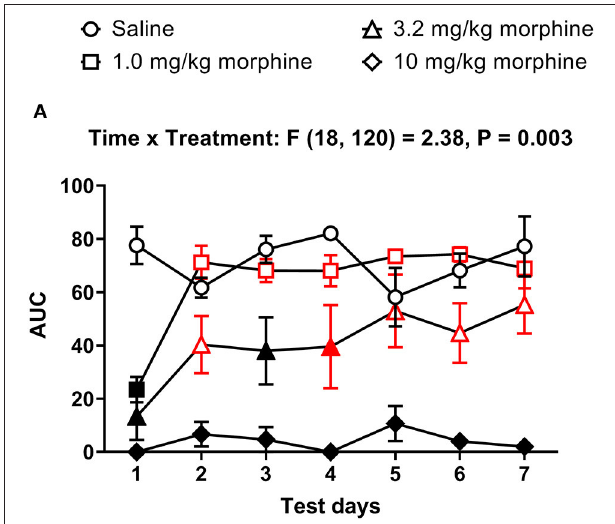
FIGURE 5 | Time course of repeated morphine treatment on nesting behavior. (A) The area under the curve (AUC) of nesting scores recorded daily in mice treated with saline, 1.0, 3.2 or 10 mg/kg/day morphine s.c. Red points indicate significance ( P < 0.05) vs. day one indicated by a significant time x treatment interaction by repeated measures two-way ANOVA with Dunnett’s test. Filled points indicate significance vs. saline by Bonferroni’s post-hoc analysis.